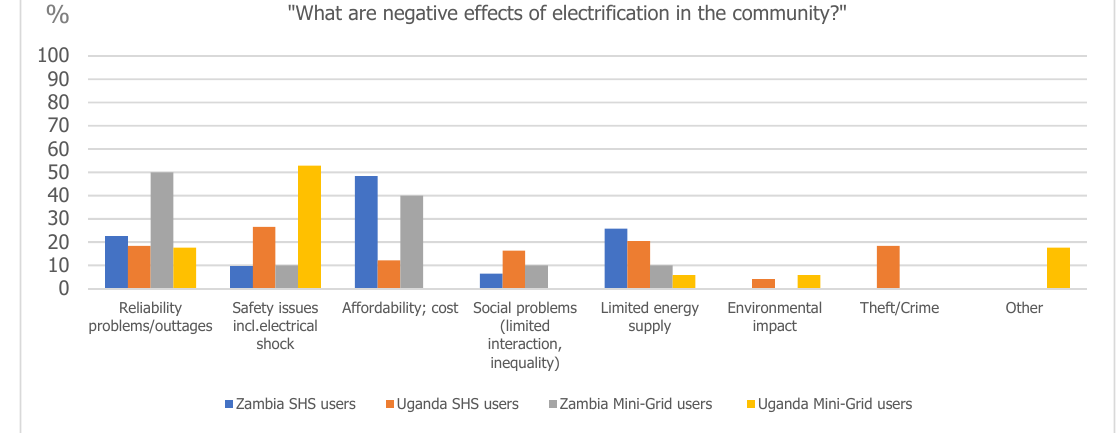
Figure 14. Perceived negative impacts of electrification among various subgroups; Multiple responses; Responses in %.